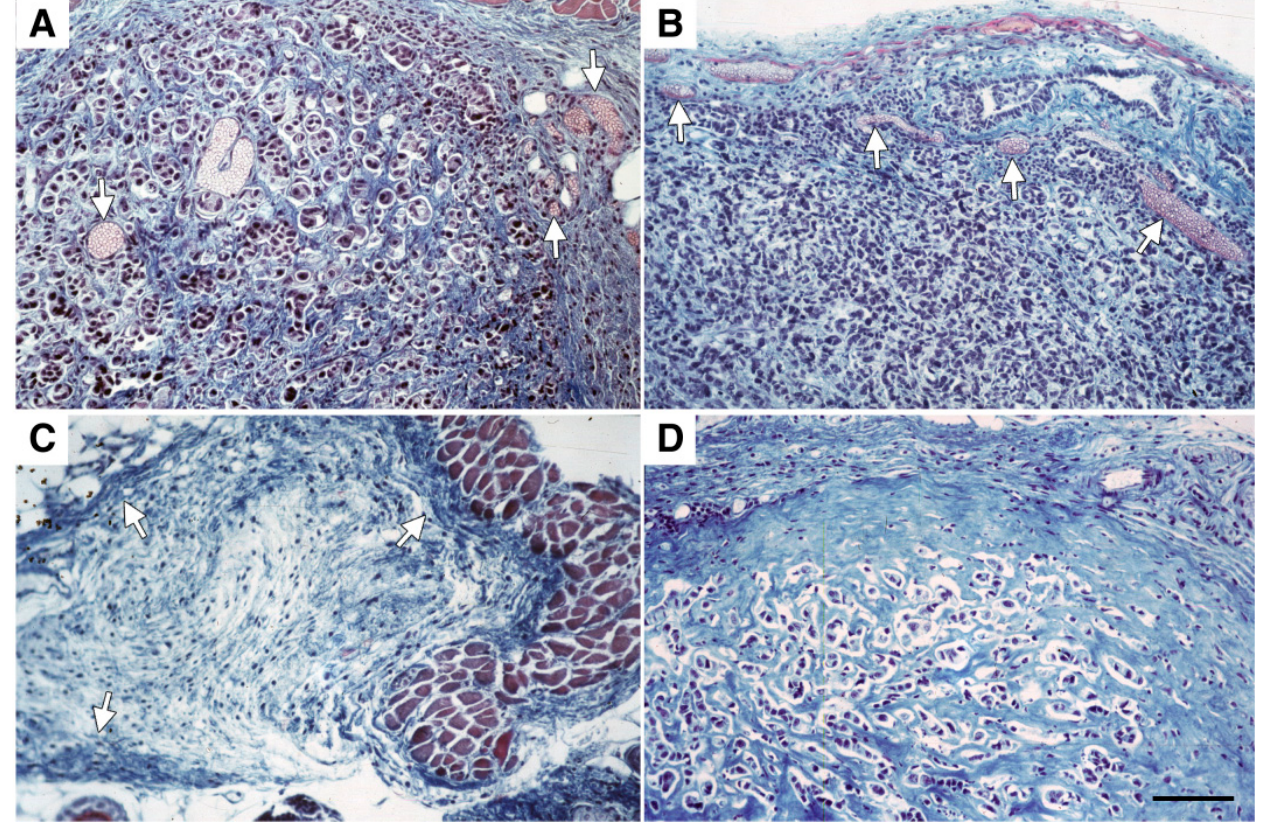
Figure 3. Histology of mammary tumors 6 months after Ad sflt injection. ( A ) Untreated tumors show intense vascularization (arrowheads) at d = 0. ( B ) At 26 weeks, AdCMV. β gal-infected tumors consist of highly packed tumor cells with a thin fibrous capsule and a well-developed peri-tumor hyper- vasculature border zone (arrowheads). ( C ) Twenty six weeks after infection, Ad sflt -treated tumors are hypovascularised and exhibit a thicker fibrous capsule (arrowheads). The tumor is characterized by increased necrotic areas. ( D ) A tumor in regression after treatment with Ad sflt exhibits a high content of fibrous tissue and necrotic cells. All tumor sections were stained with Masson trichrome. The same magnification was used for all sections. Bar = 22 m.